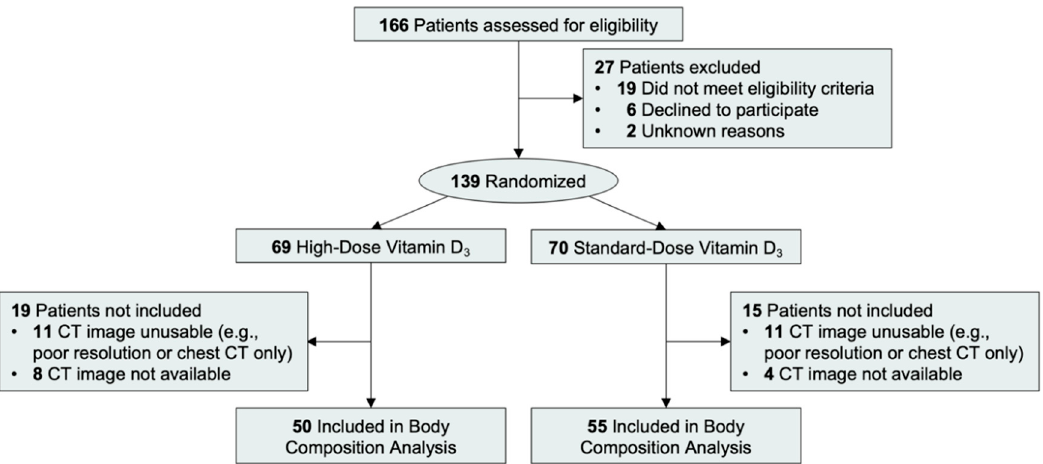
Figure 1. Flow of participants.